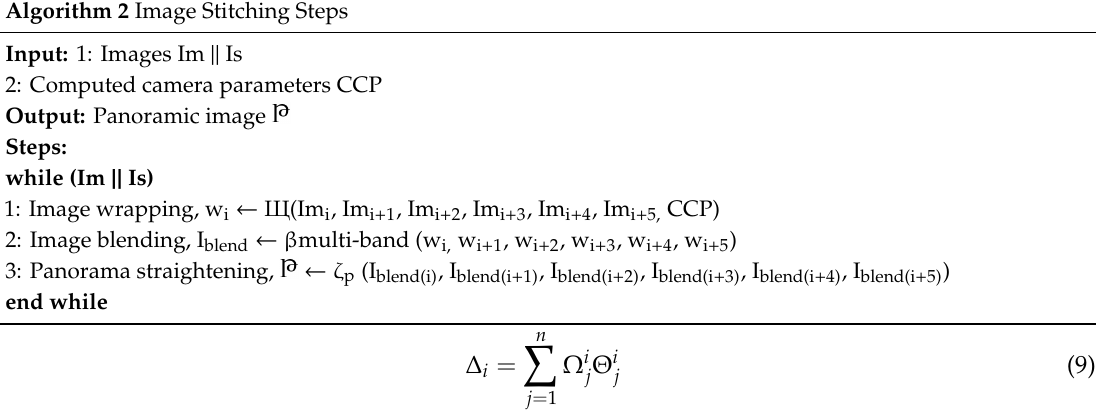
Algorithm 2 Image Stitching